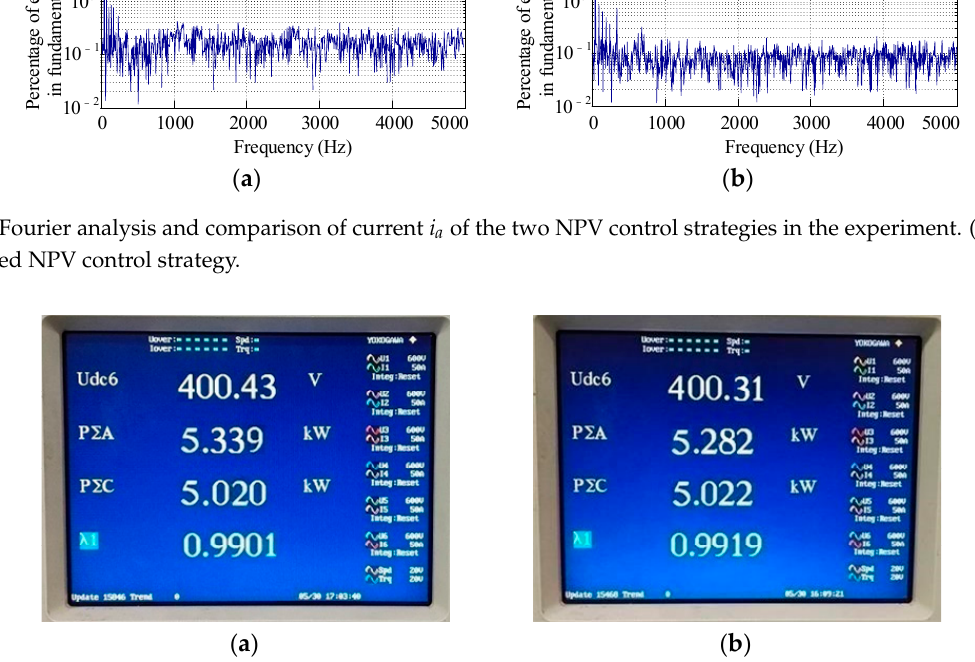
Figure 14. Input power and power comparison of the two NPV control strategies in the experiment. ( a ) ZSV-J; ( b ) the proposed NPV control strategy. Table 3. Efficiency, THD , power factor, cost, and complexity comparison of the two NPV control strategies. Input Power Control Methods